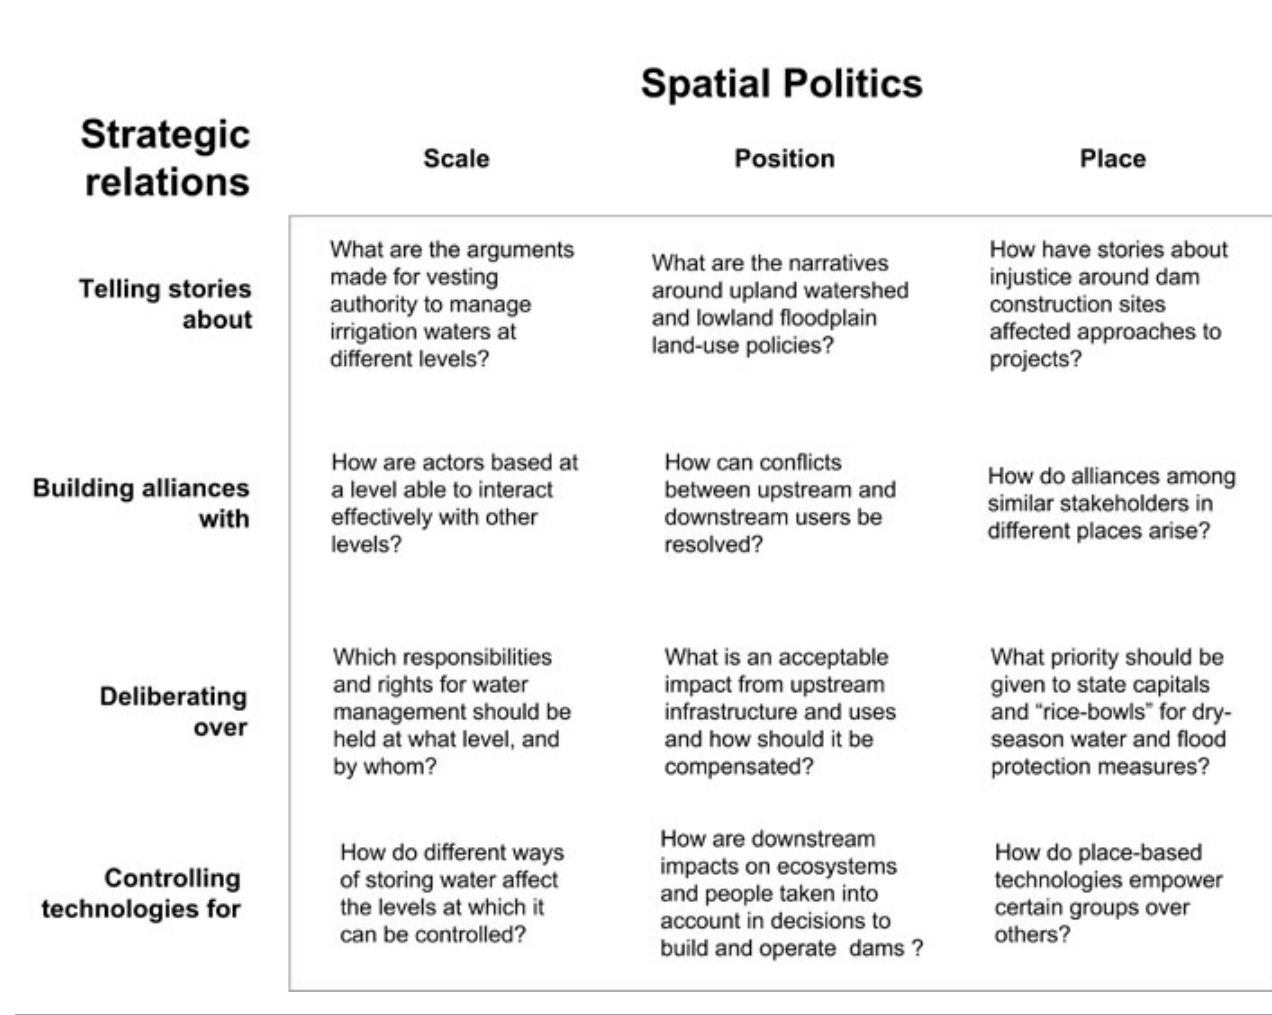
Fig. 4. Examples of analytical questions about strategic relations of actors in